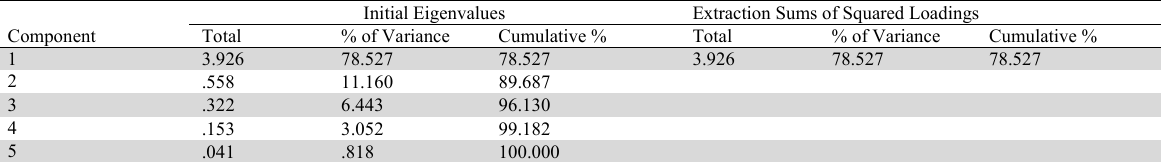
Total variance explained Component